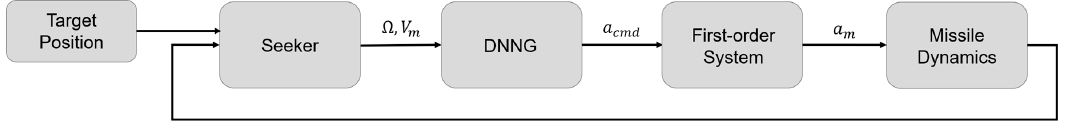
Figure 12. Conceptual diagram of the missile system with added first-order system.